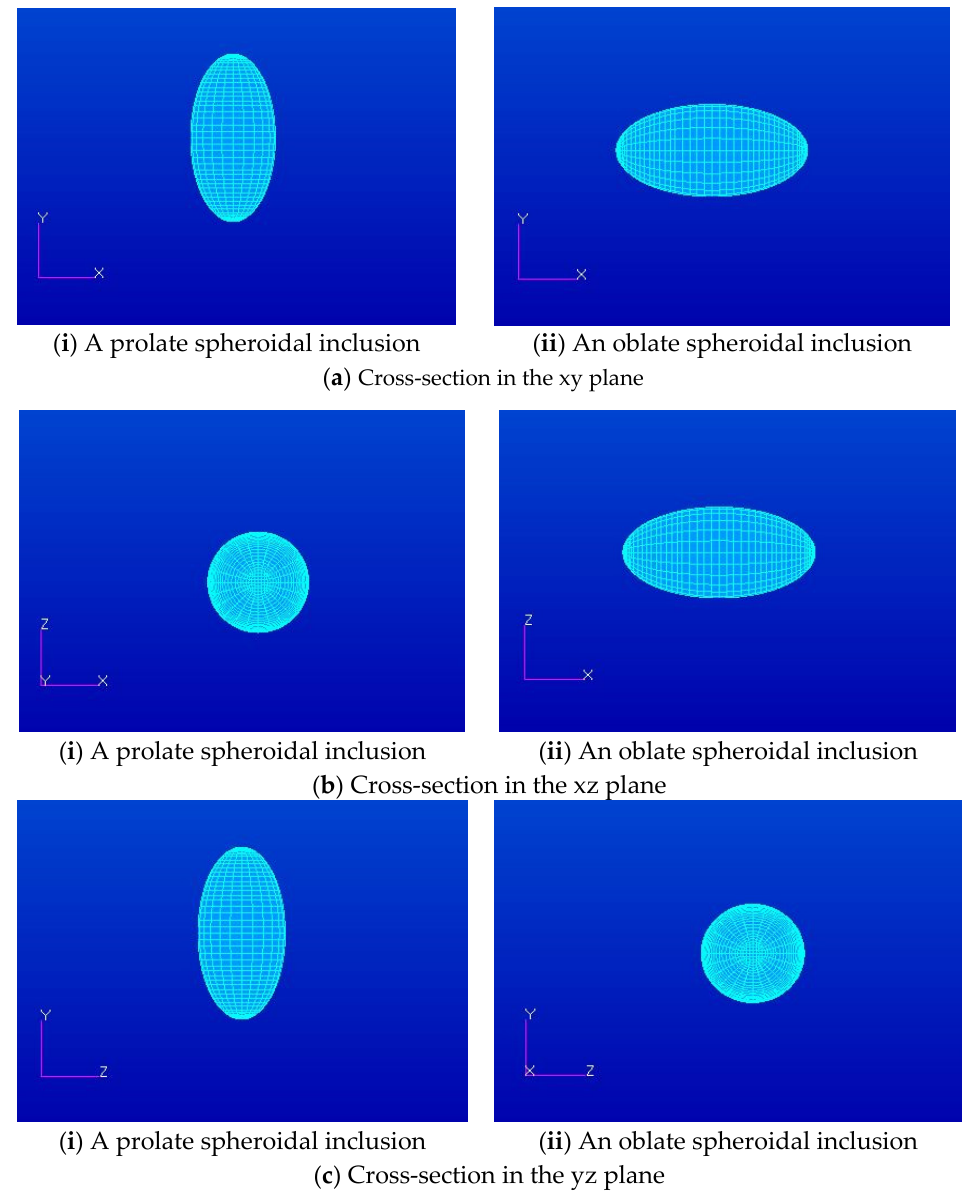
Figure 26. Cross-section in the ( a ) xy plane, ( b ) xz plane and ( c ) yz plane of ( i ) prolate spheroidal (with an aspect ratio of 0.5) and ( ii ) oblate spheroidal (with an aspect ratio of 0.5) inclusions under remote shear loading.